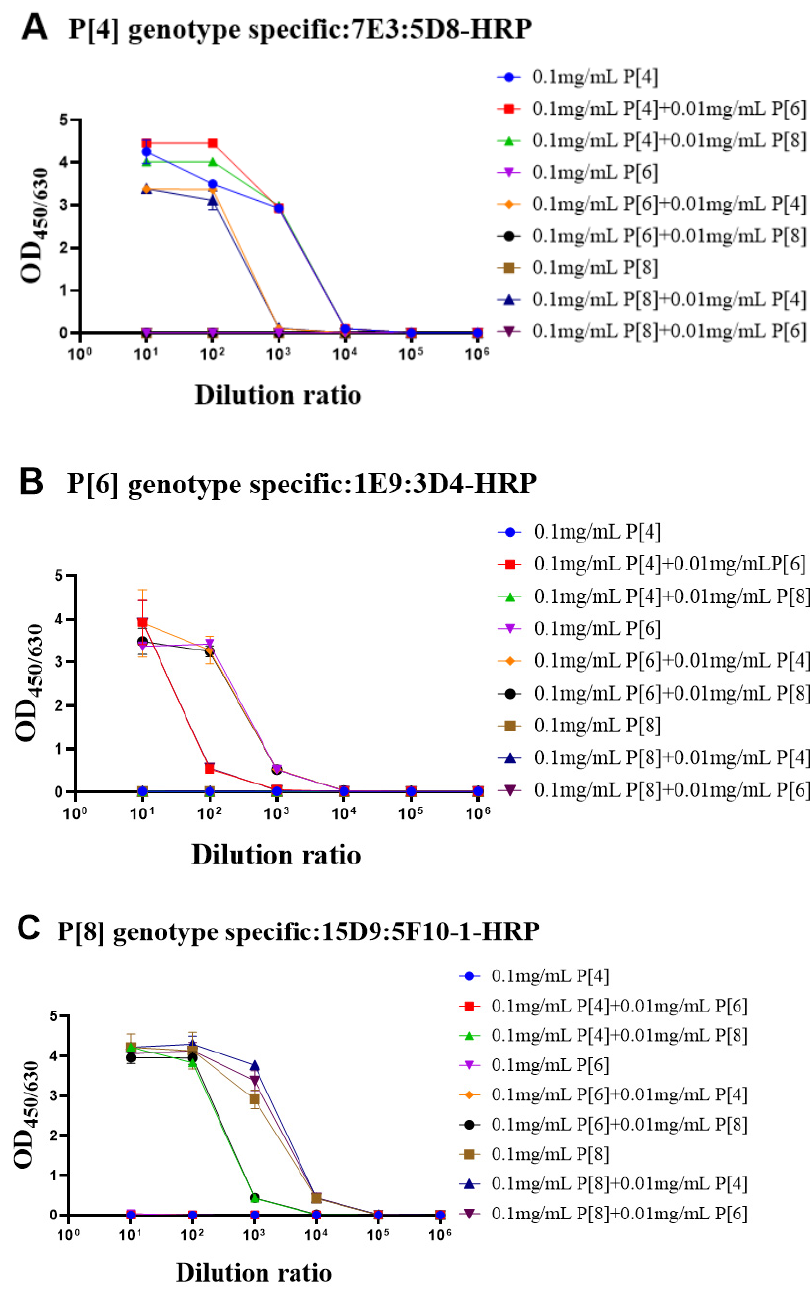
Figure 4. The evaluation of the identity of purified VP4* proteins by the genotype-specific mAb pairs. In order to confirm whether the ELISA systems can be used to detect protein contamination, we mixed 10 µ g/mL of the other two VP4* proteins into P[4], P[6], and P[8]-VP4* protein, respectively, and then the mixtures were detected by the three genotype-specific mAb pairs. As shown in the ( A – C ), the three ELISA detection systems can accurately identify the P[4], P[6], and P[8]-VP4* in the mixed samples. All the experiments were performed in two replicates, and the error bars represent the standard deviation of each group.